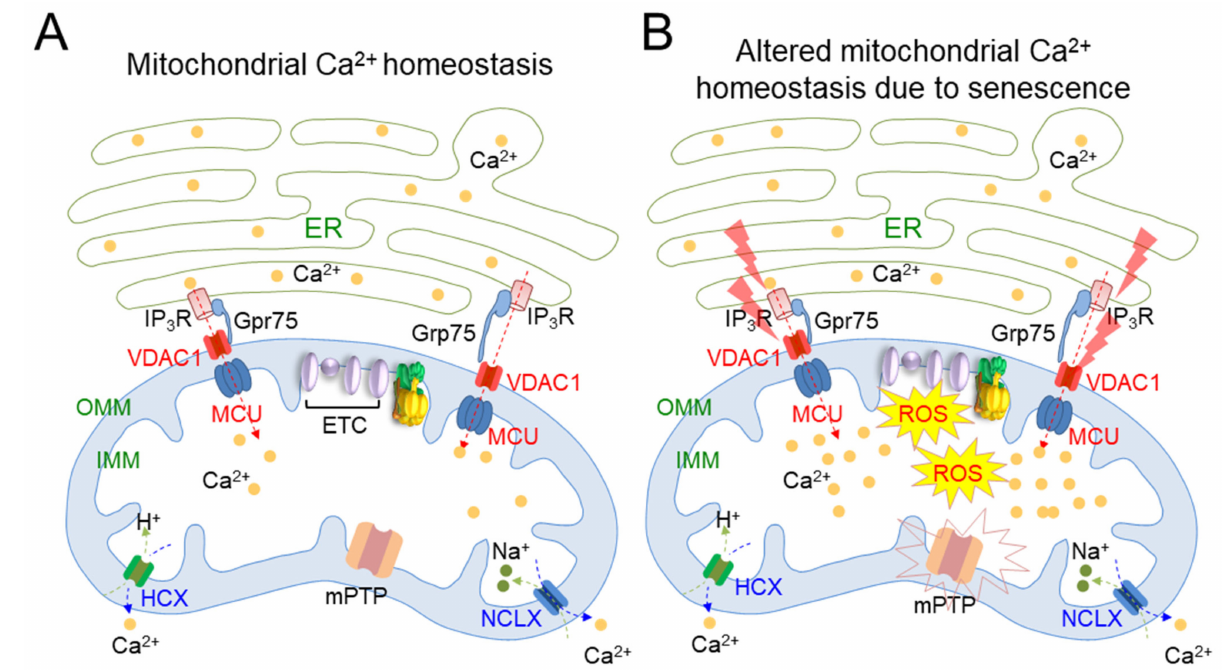
Figure 3. Schematic representation of the basic mechanisms of mitochondrial Ca 2+ homeostasis. ( A ) Mitochondrial Ca 2+ homeostasis is regulated by protein channels localized in the mitochondrial inner membrane (IMM) and mitochondrial outer membrane (OMM), and also by crosstalk with the ER. ER: endoplasmic reticulum; IP 3 R: inositol 1,4,5-trisphosphate receptor; VDAC: voltage-dependent anion channels; MCU: mitochondrial calcium uniporter; HCX: H + /Ca 2+ exchanger; NCLX: Na + /Ca 2+ exchanger; mPTP: mitochondrial transition pore. ( B ) Senescence triggers IP 3 R to release Ca 2+ from the ER and causes VDAC/MCU channels to initiate the inward flow of Ca 2+ , leading to mitochondrial Ca 2+ overload. Mitochondria overloaded with Ca 2+ cause the collapse of the electron transfer in the ETC, resulting in increased electron leak and consequent mitochondrial ROS generation. An increase in mitochondrial ROS due to mitochondrial Ca 2+ overload induces the sustained opening of the mitochondrial transition pore (mPTP). The lightning bolt indicates stress caused by